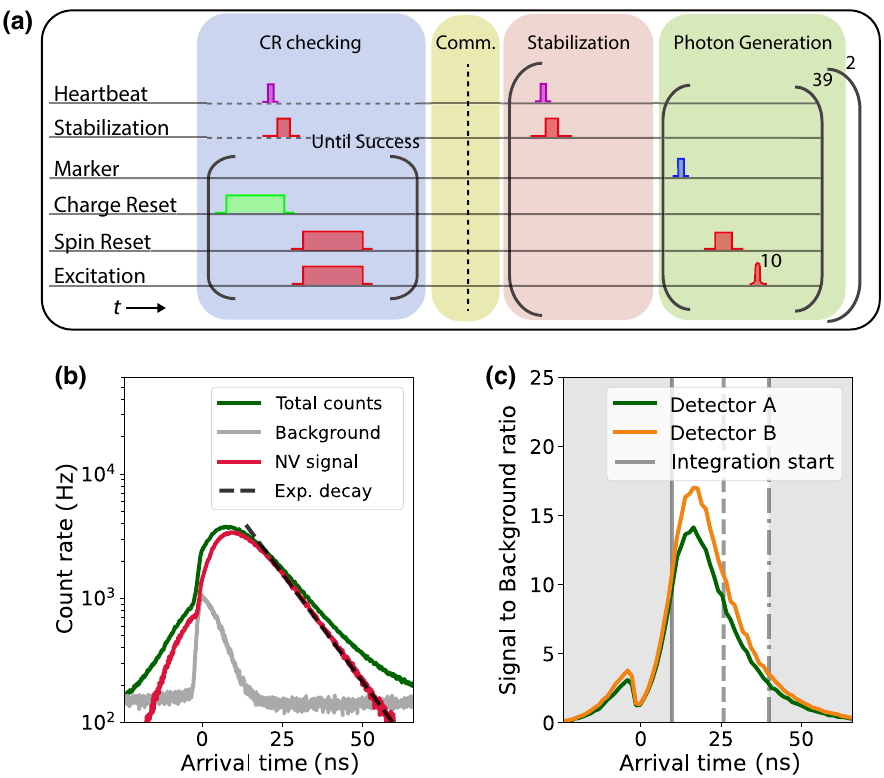
FIG. 3. The generation of single photons using a fixed heartbeat. (a) The measurement sequence for synchronized generation of single photons using a distributed heartbeat. For detailed timing, see the Supplemental Material [25]. (b) A histogram of the SNSPD counts in a single excitation round, averaged over approximately 2.8 × 10 11 repetitions and analyzed in 80-ps bins. The measured count rate (green) is a combination of background (gray) and NV fluorescence (red), which is calculated by subtracting the background from the total counts. The dotted line depicts exponential decay with a 12.5-ns lifetime and serves as a guide to the eye. The NV signal before time 0, the peak of the excitation pulse, is due to the nonperfect extinction ratio of the devices generating the optical excitation pulse. The background data are taken continuously over 24 h to include any drifts that occur over the same time scale as the signal data. (c) The signal-to-background ratio (SBR) for both detectors as calculated from data in (b) (solid lines). The solid vertical gray line shows the start of our chosen detection window, whereas the dashed (dash-dotted) line shows the end for the data shown in Fig. 4(a) [Fig. 4(b)]. The difference between the two curves is due to nonequal detector